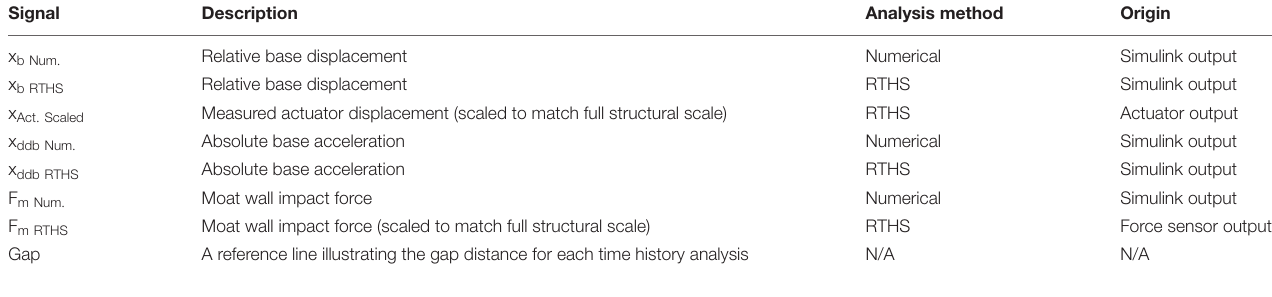
TABLE 2 | Description of signals contained within Results section.